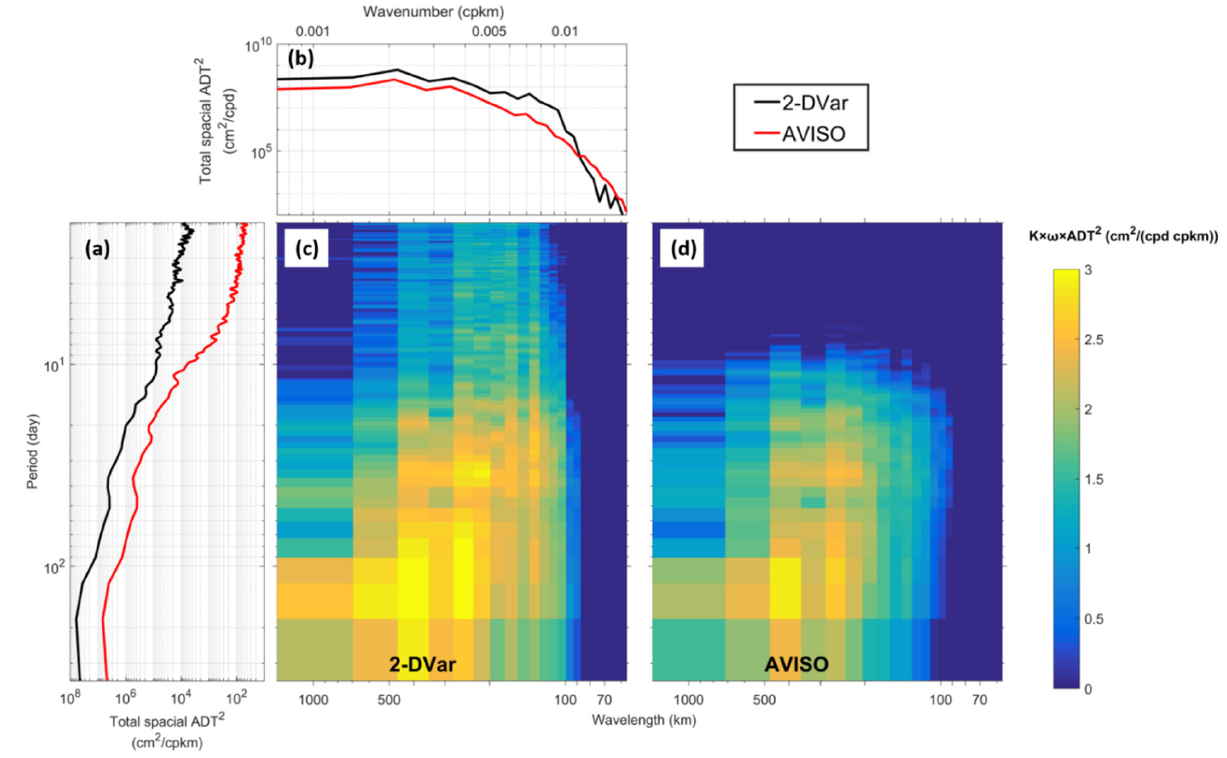
Figure 9. ( a ) Sum of FPSD over time for 2-DVar (black line) and AVISO (red line); ( b ) sum of PSD over space for 2-DVar (black line) and AVISO (red line); ( c ) horizontal wavenumber frequency spectral density of ADT in 2-DVar; and ( d ) horizontal wavenumber frequency spectral density of ADT in AVISO.